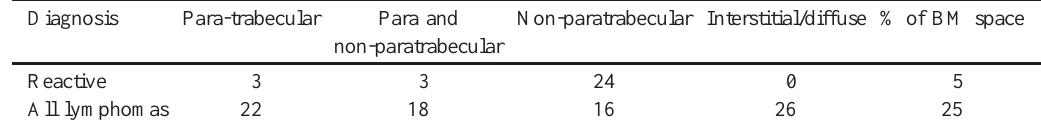
Table 6 Patterns of lymphoid infiltration in bone marrow ( n = number of cases) and the mean percentage of bone